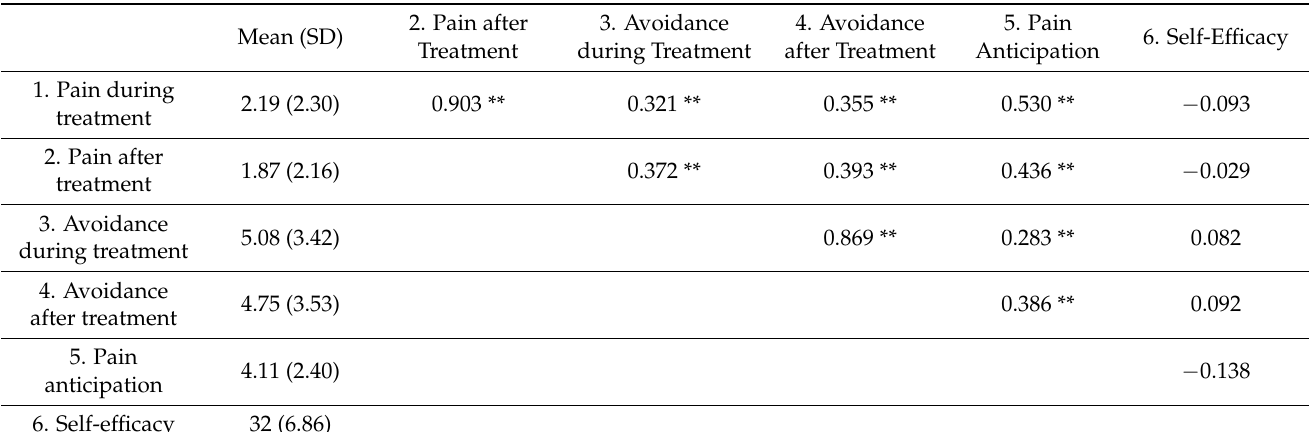
Table 1. Means, standard deviations, and Pearson correlations between study variables ( n = 99).